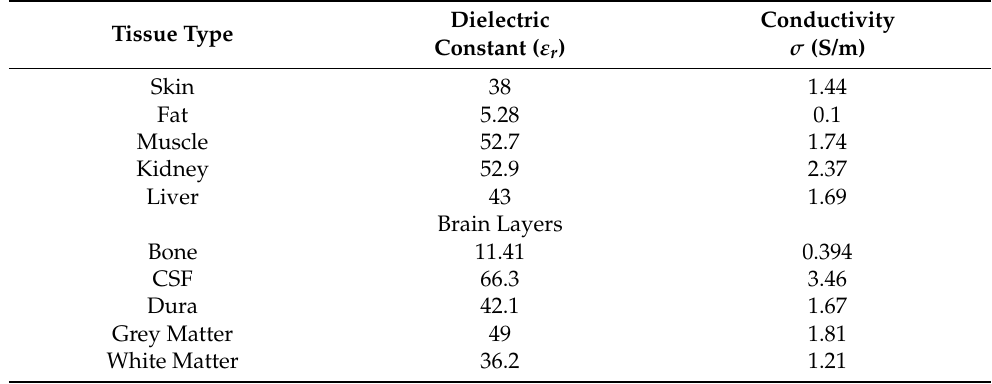
Table 1. The dielectric properties of the different layers of the human body at 2.45 GHz [38,39].